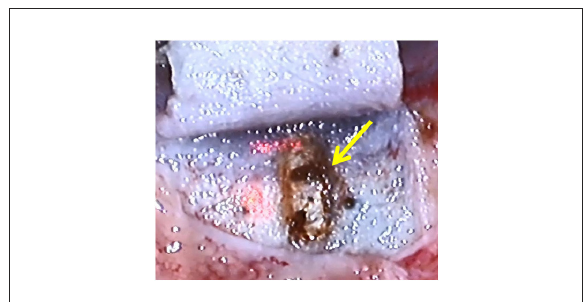
FIGURE3 Manually dissected outer wall of